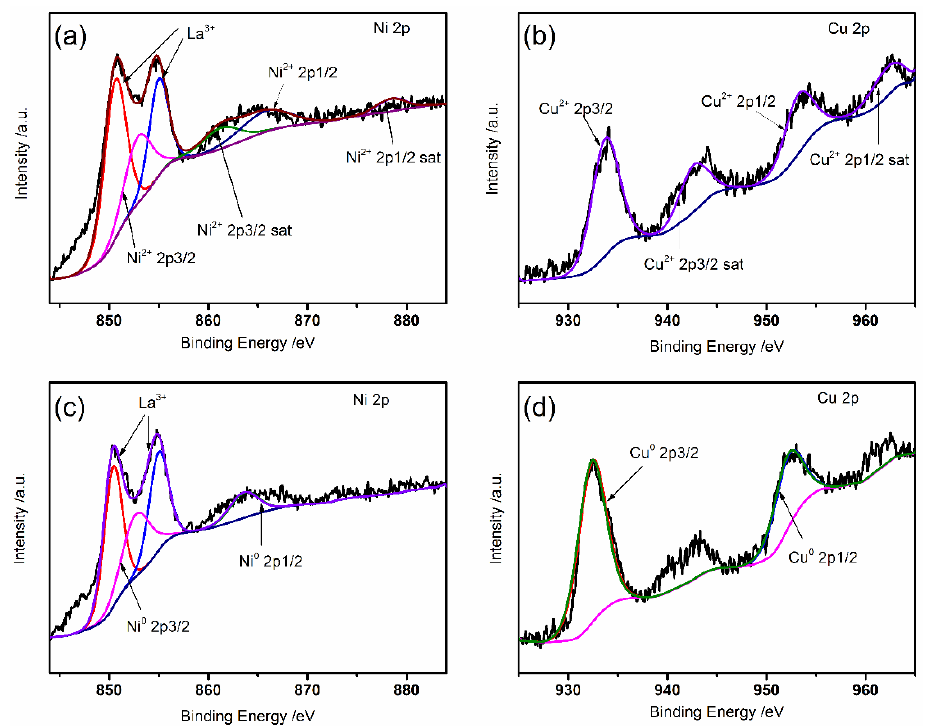
Figure 2. The chemical valence state of the elements. ( a ) Ni 2p and ( b ) Cu 2p XPS of unreduced LSCrM(NC) x ; ( c ) Ni 2p and ( d ) Cu 2p XPS of reduced LSCrM(NC) x